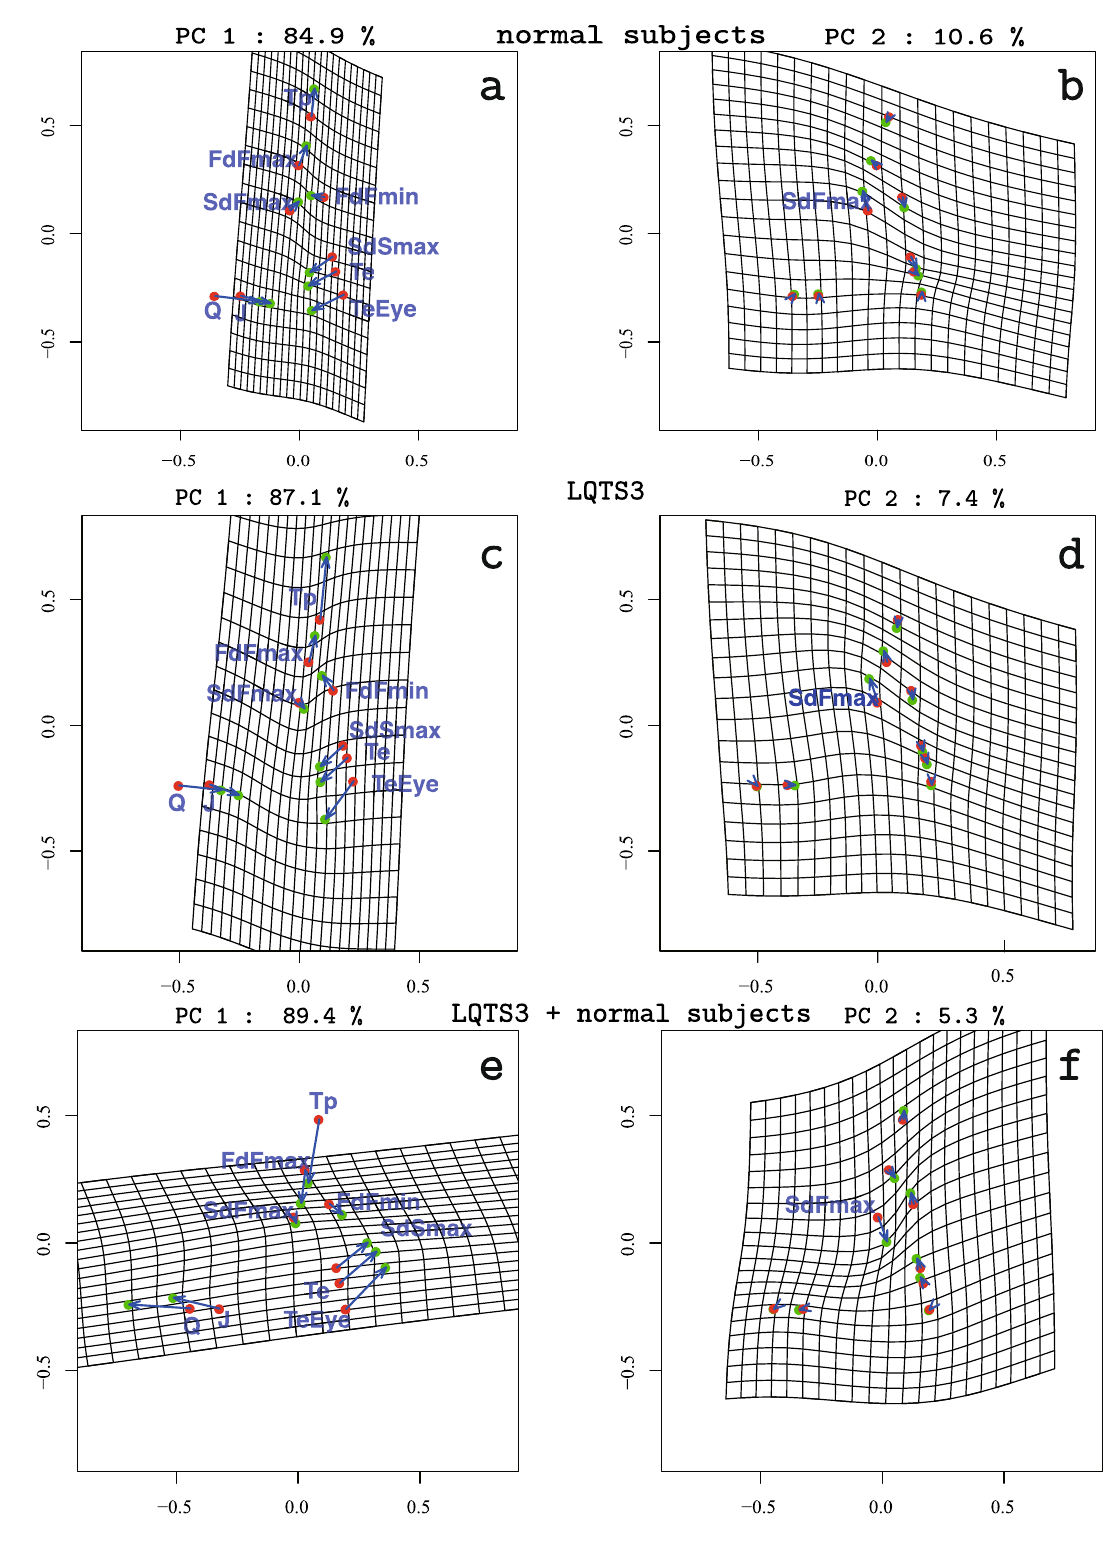
Figure 5. Changes in PC1 and PC2 in the normal subjects ( a , b ), patients with LQTS3 ( c , d ) and a combination of the two groups of subjects ( e , f ). A square grid is drawn on the mean shape (red points) and deformed using a pair of thin-plate splines to an icon (green points, mean + 1 * standard deviation) along each PC (indicated by the blue vector from the mean to the icon). PC1 of the normal subjects ( a ) and PC1 of the LQTS3 patients ( c ) show that Q, J, SdSmax, Te and TeEye are attracted to the vertical center and narrowed. FdFmax and Tp are displaced upwards. The SdFmax of PC2 of the normal subjects ( b ) and that of the LQTS3 patients ( d ) is displaced to the upper left. In the case of the combination of the two types, PC1 ( e ) for the Procrustes mean shape shows the displacement to the left of Q and J. FdFmax and Tp are displaced downward. SdSmax, Te, and TeEye are pulled to the upper right. There are almost no changes in SdFmax and FdFmin. PC2 ( f ) for the Procrustes mean shape shows a displacement of SdFmax to the lower right. R version 4.0.2 URL https:// www.R- proje ct.